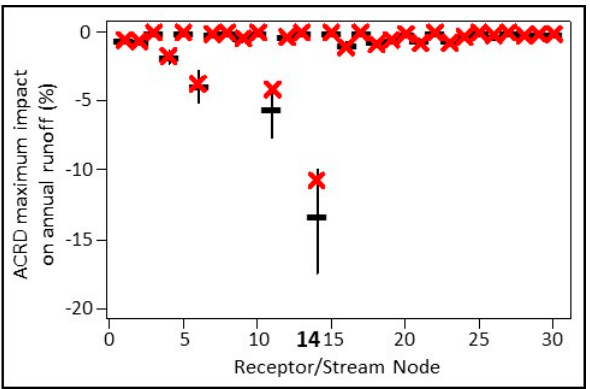
Figure 9. Distribution of ACRD maximum impact on annual runoff, modelled using 100 stochastic replicates (plots show median and 10th and 90th percentile values, the red crosses show results when the 1923–2012 rainfall sequence is used (as in Figure 3).